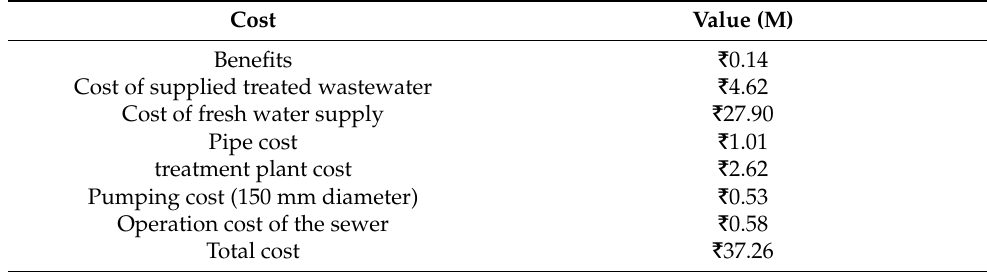
Table 10. Annual cost split up for implementation of decentralized wastewater reuse: IIT Madras